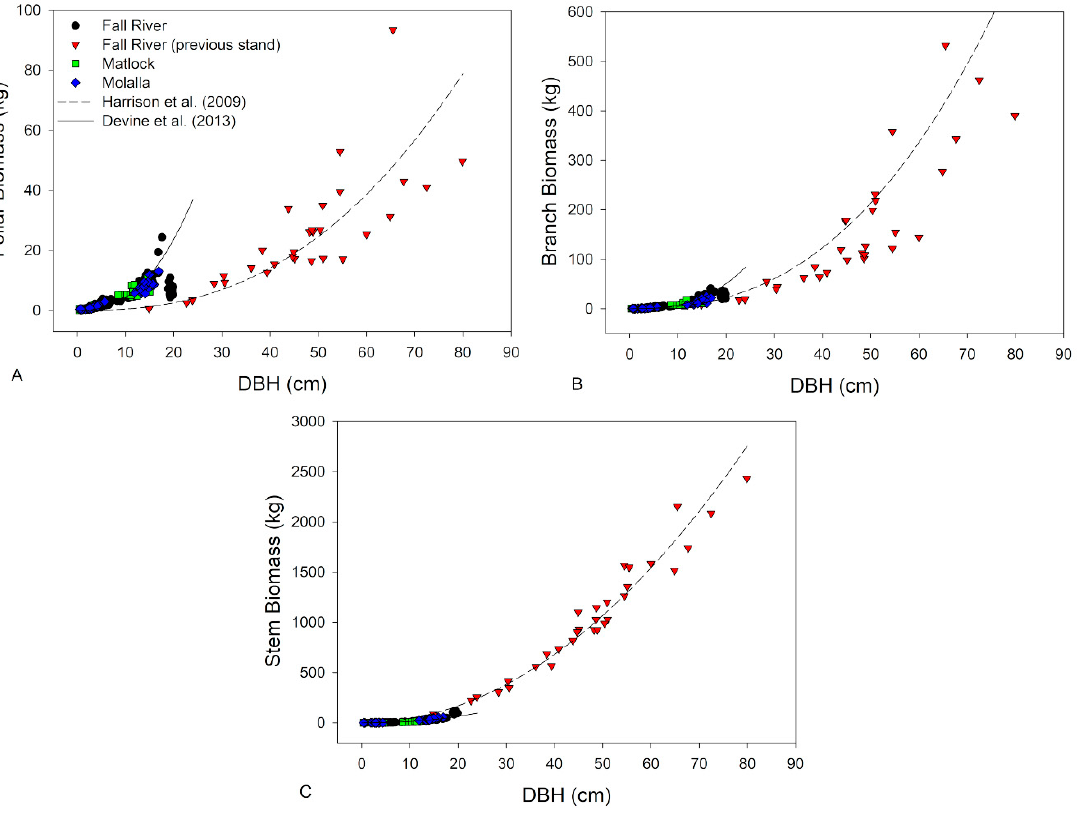
Figure 3. Relationships between DBH and foliar ( A ), branch ( B ), and stem ( C ) at Fall River (current stand), Fall River (previous stand), Matlock, and Molalla. Previous biomass allocation equations from Fall River, Matlock, and Molalla are shown